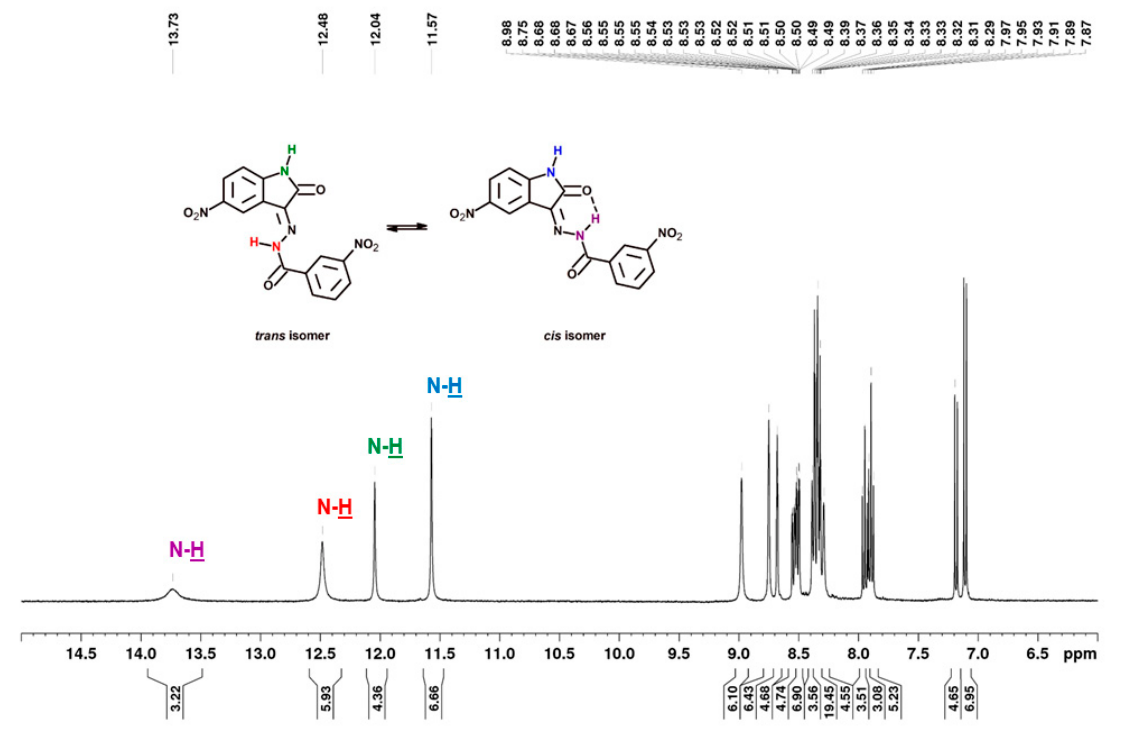
Figure 7. 1 H NMR spectrum (400 MHz) of 3-nitro- N ’-[5-nitro-2-oxo-1,2-dihydro-3 H -indol-3-ylidene]benzohydrazide (3h) in DMSO-d 6 .